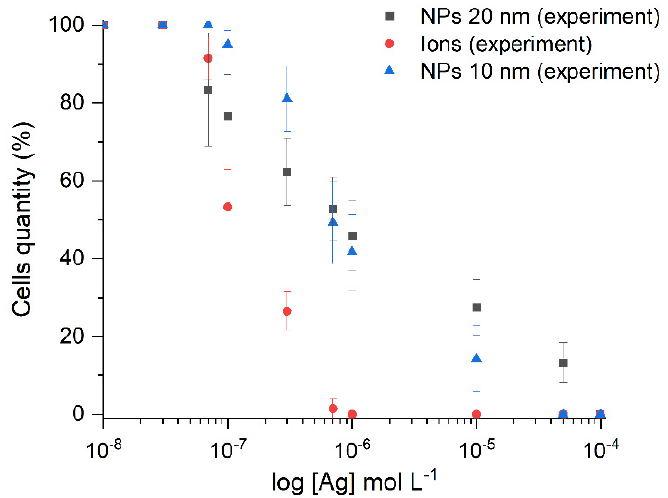
Figure 6. Quantity of cells: result of inhibition by various concentrations of